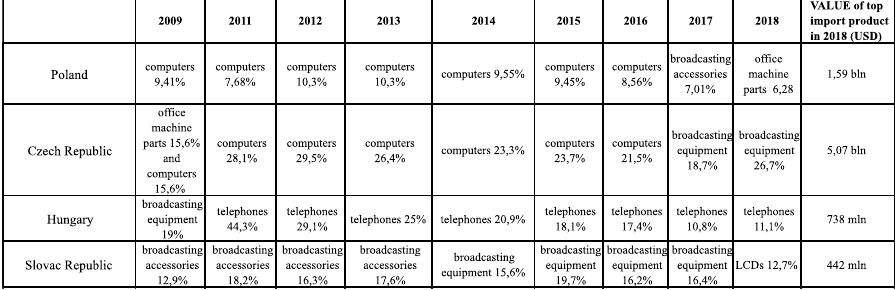
Source: Own elaboration based on OEC,